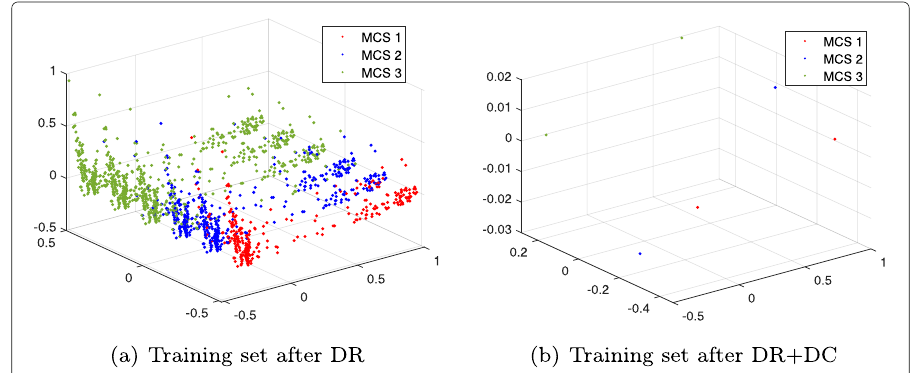
Fig. 16 Variation of training set along with DRDC (training set 6). a Training set after DR. b Training set after DR + DC